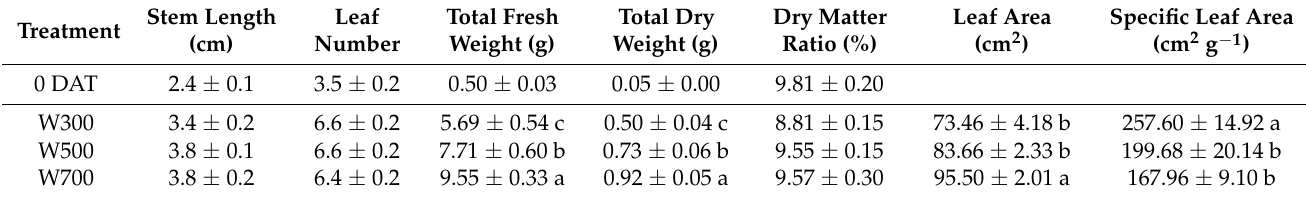
Table 1. Effect of photosynthetic photon flux density (PPFD) on the growth of ‘Micro-Tom’ 9 days after treatment (DAT) in Experiment 1. W300, W500, and W700 denote PPFD of 300, 500, and 700 µ mol m − 2 s − 1 , respectively. Each value represents the mean ± standard error. Different letters in a column indicate significant differences among the treatments based on the Tukey − Kramer’s test ( n = 8) at p < 0.05.